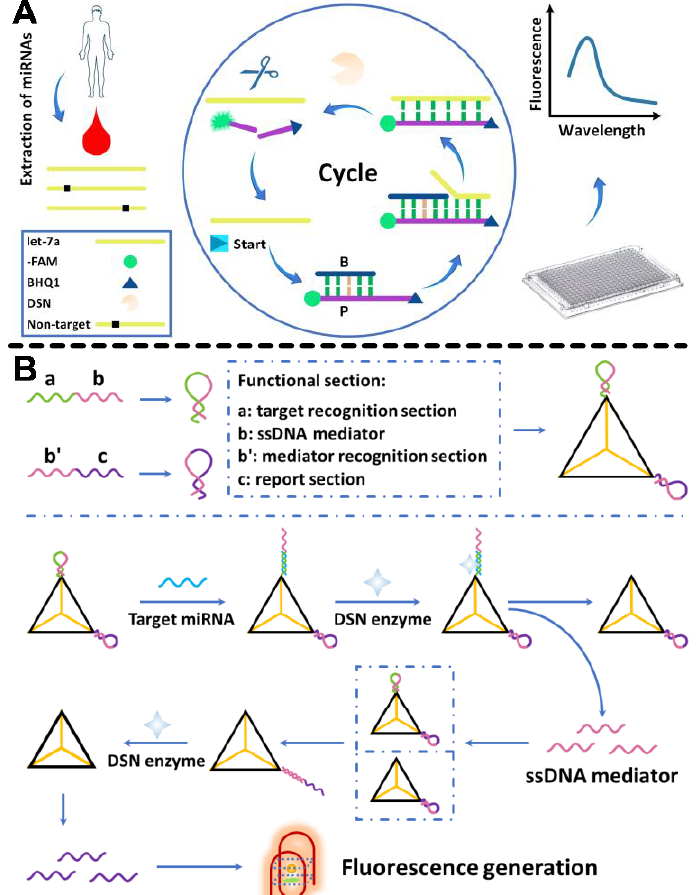
Figure 1. ( A ) Schematic illustration of the target invasion-triggered signal amplification for miRNA identification. ( B ) The proposed miRNA detection mechanism. Functional separation of HMBs and tetrahedral nanoprobe assembly (top panel). The whole operational procedure (bottom panel). Reproduced with permission from Refs. [46,47], respectively. Copyright 2022, Elsevier.